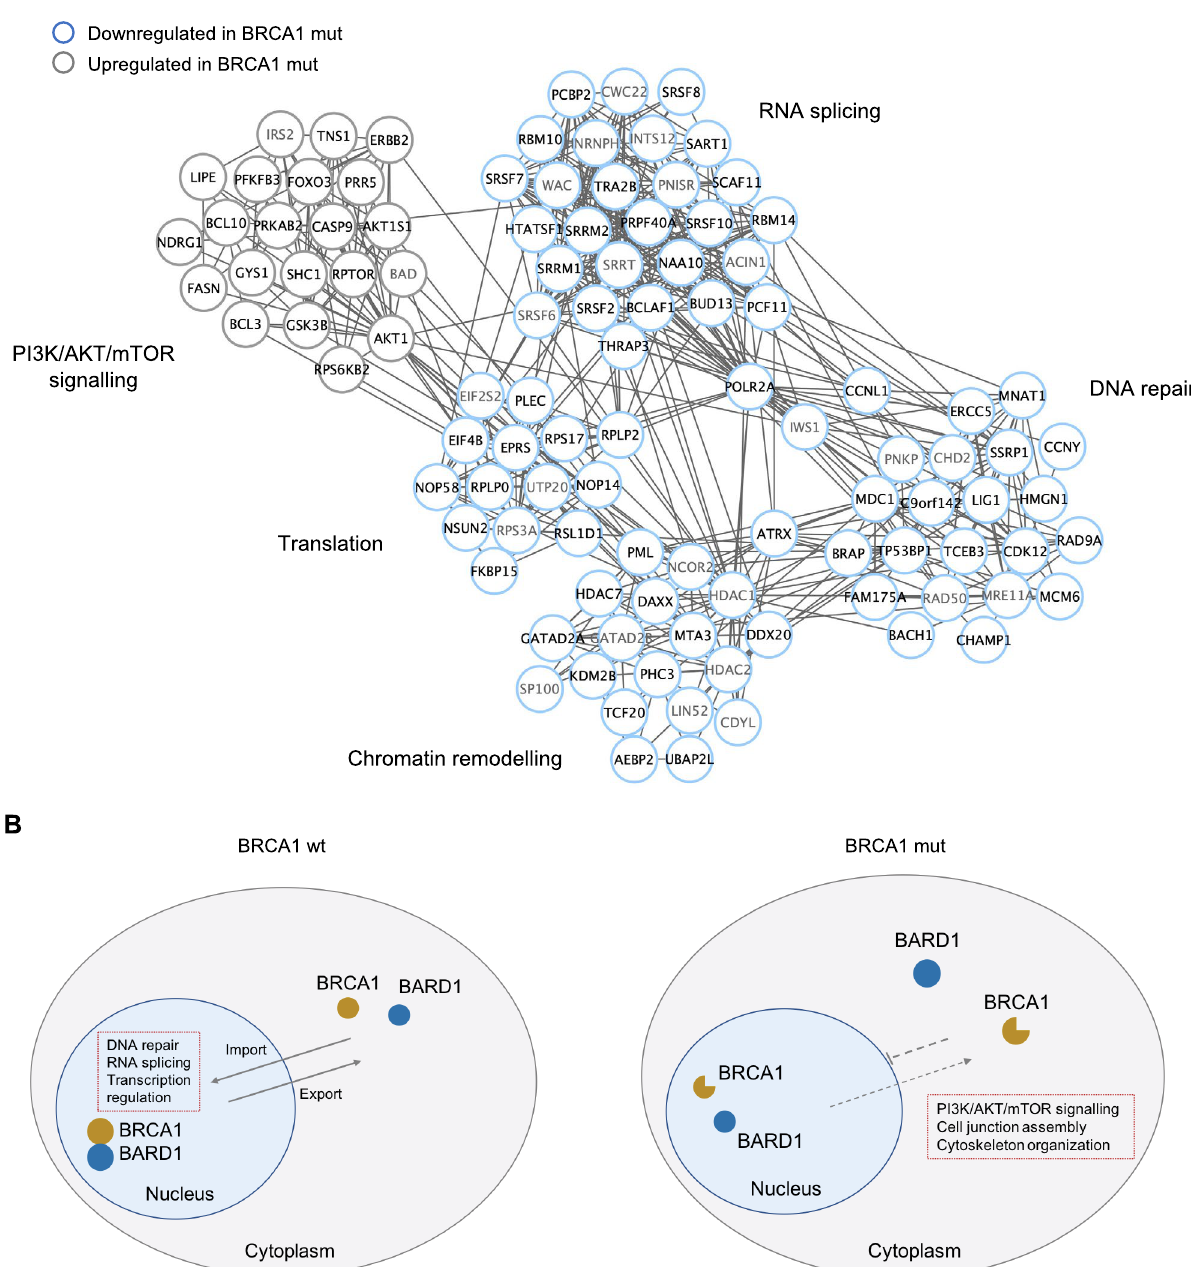
Figure 5. BRCA1-dependent phosphorylation signaling events and subcellular localization in ovarian cancer. (A) Functional network analysis of the regulated phosphorylated proteins identified in our study (nodes with black label) and their interacting proteins (nodes with grey label) (q-value < 0.05). The edges represent known protein–protein interactions based on the InWeb_IM database (interaction score > 0.9) and visualized with Cytoscape (ClusterOne plugin). RNA splicing, p < 0.001; translation, p < 0.001; DNA repair, p = 0.002; chromatin remodeling, p = 0.007; PI3K/AKT/mTOR pathway, p = 0.009 (one-tail Mann–Whitney U test). (B) Schematic representation of BRCA1 subcellular compartmentalization in BRCA1wt and BRCA1mut tumors. Changes in subcellular localization may be caused by changes in protein shuttling and import into the nucleus, thus reflecting in differential cellular signaling events in ovarian cancer